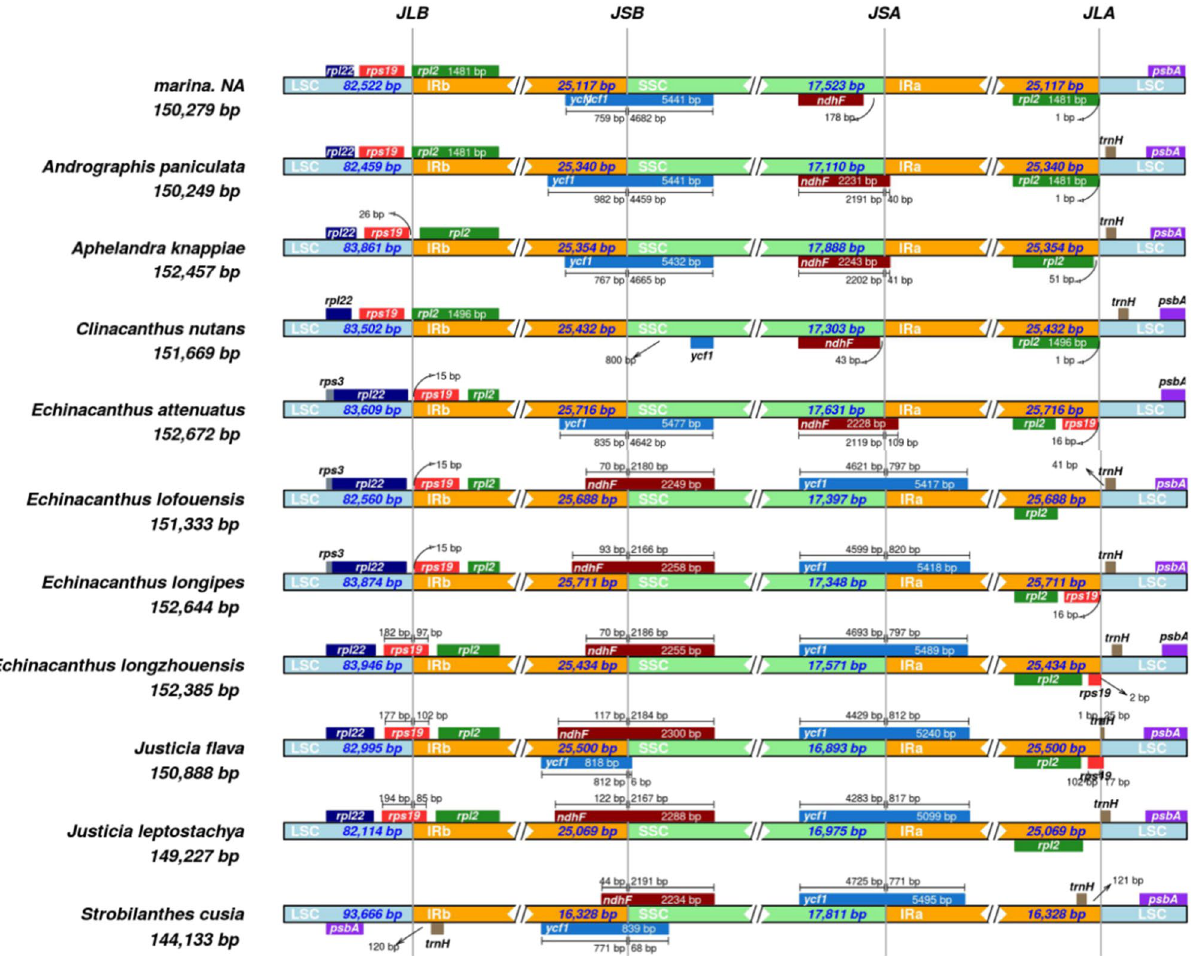
Figure 5. Distance between the adjacent genes and junctions of Large single Copy (LSC), two inverted repeats (IR) and Small Single Copy (SSC) in A. marina and 10 other related species. boxes below and above the lines represent the genes located on the border of LSC, IR and SSC. The figure represents the changes in the length and location of certain genes across these